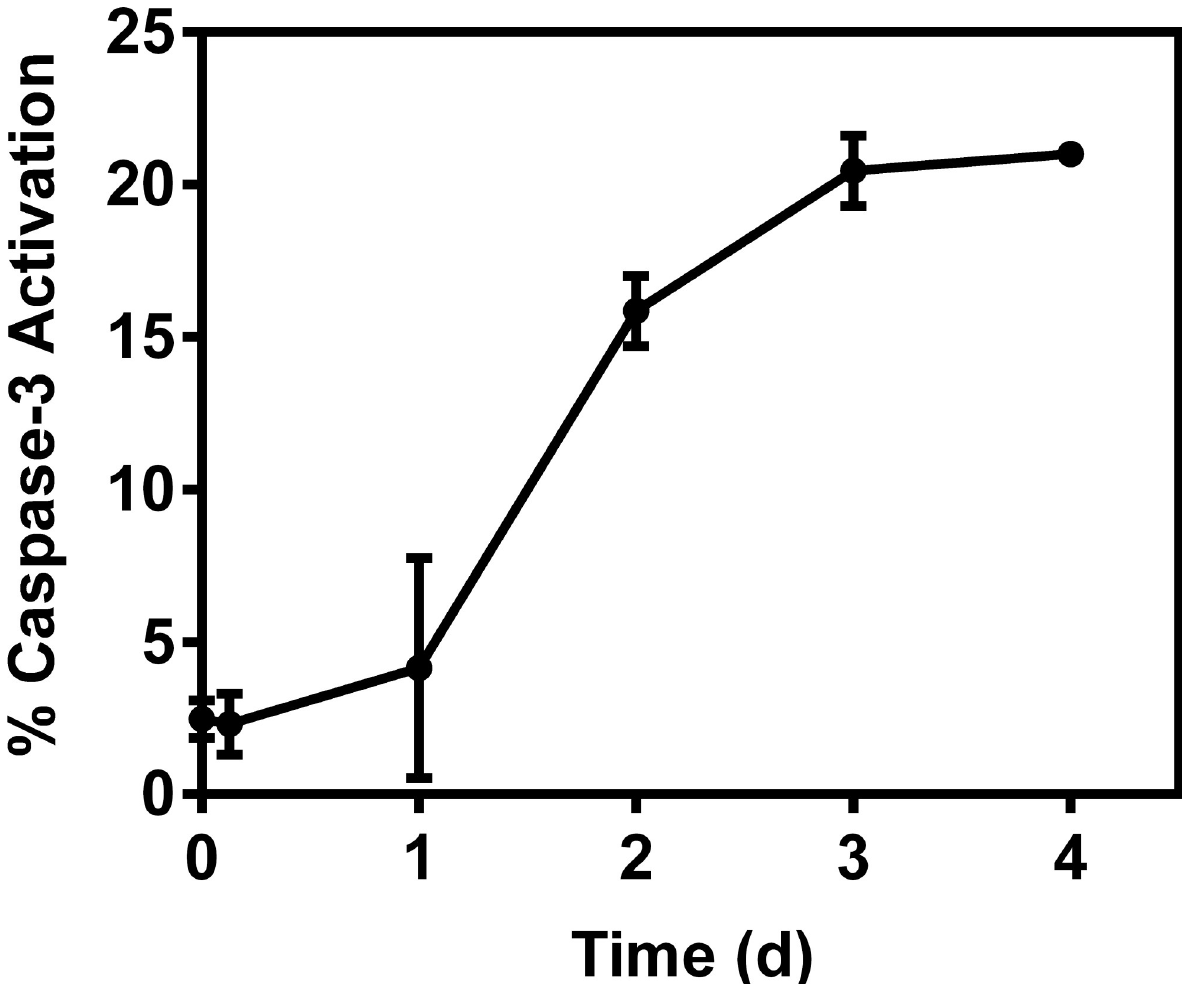
Fig 9. DOX induced caspase-3 activation in rat cardiomyocytes cells. H9c2 cells were treated with DOX (0 and 10 μ g/mL) for 1h, recovered for 0–4 days and caspase-3 activation was determined using flow cytometry ( χ r2 (1, N = 11) = 7.47, p = 0.19, Friedman’s